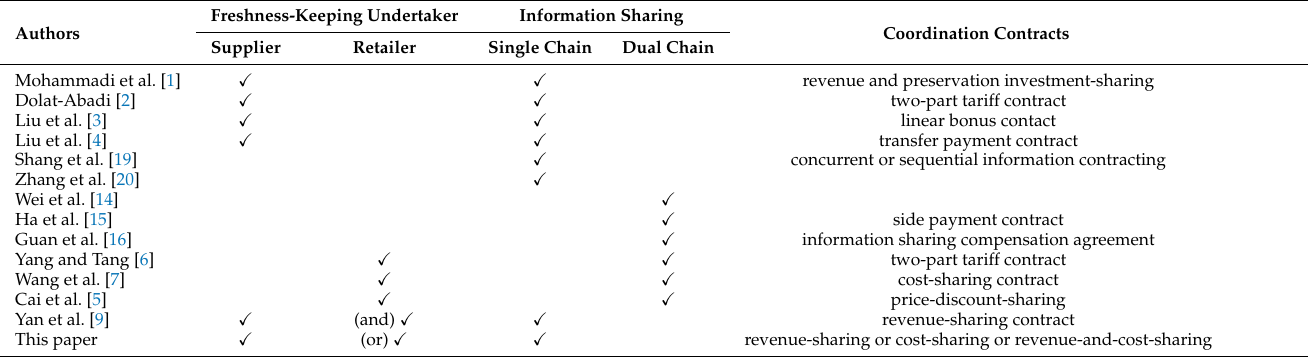
Table 1. Summary of the literature from three relevant area related to this